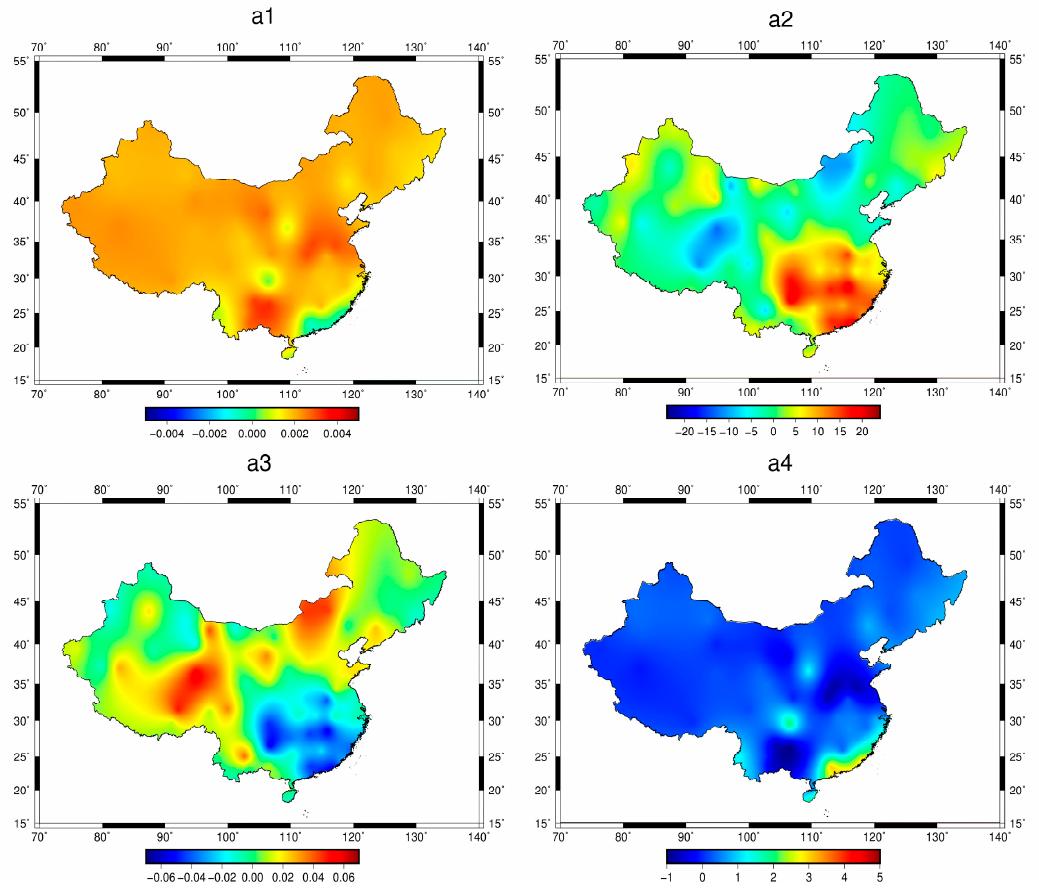
Figure 9. The distribution of the SAAS_S model coefficients. The four subfigures ( a1 – a4 ) stand for the spatial distribution of the four coefficients (a1–4), respectively.